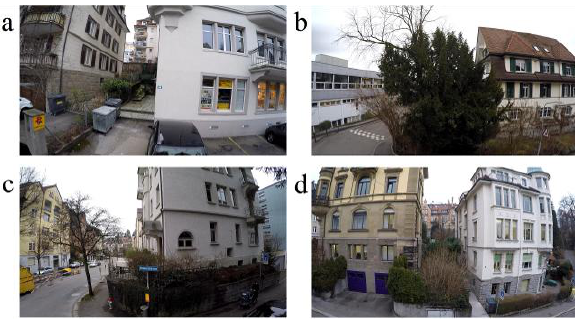
Figure 7. Examples from MAV dataset: a) 00001.jpg, b) 20001.jpg, с) 40001.jpg, d) 60001.jpg.